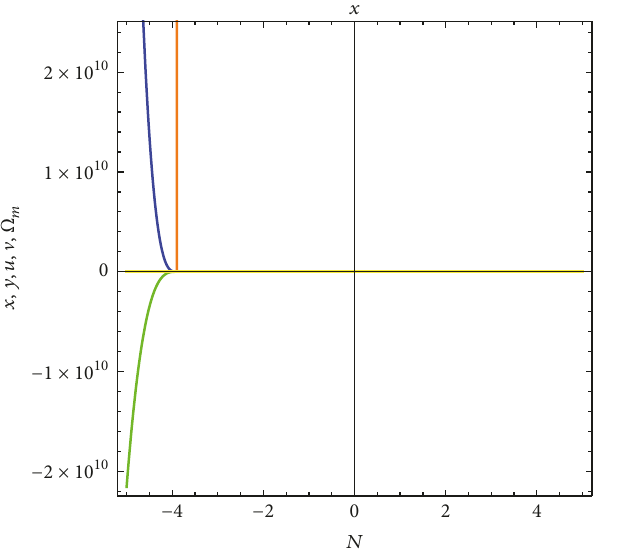
Figure 10: Plot of ( 10 ) variations of 𝑥 (blue), 𝑦 (green), 𝑢 (orange), Figure 8: Plot of ( 8 ) variations of 𝑥 (blue), 𝑦 (green), 𝑢 (orange), V (red), and Ω 𝑁 near 𝑃 𝛾 = 1 , 𝛿 = 1 , and 푚 (yellow) versus 11 , for V (red), and Ω 𝑁 near 𝑃 𝛾 = 1 , 𝛿 = 1 , and 𝜆 = −0.5 . The position corresponding to 𝑁 = 0 is the fixed point 푚 (yellow) versus 9 , for 𝜆 = −0.5. The position corresponding to 𝑁 = 0 is the fixed point under consideration. under consideration.